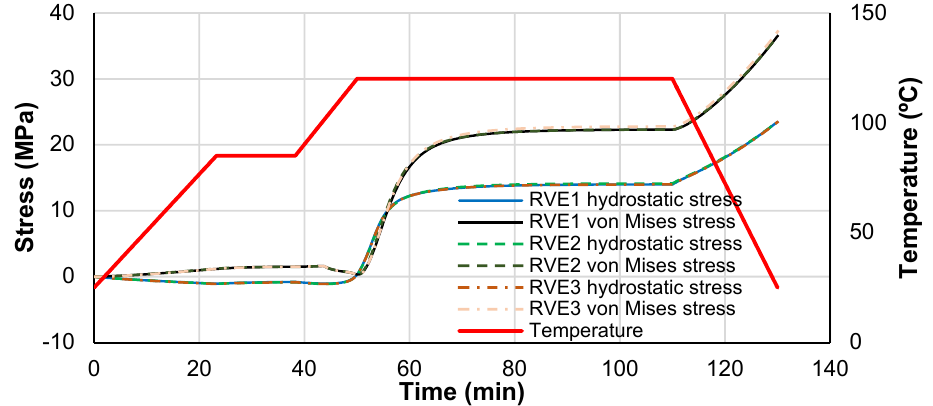
CTE of the fibers.